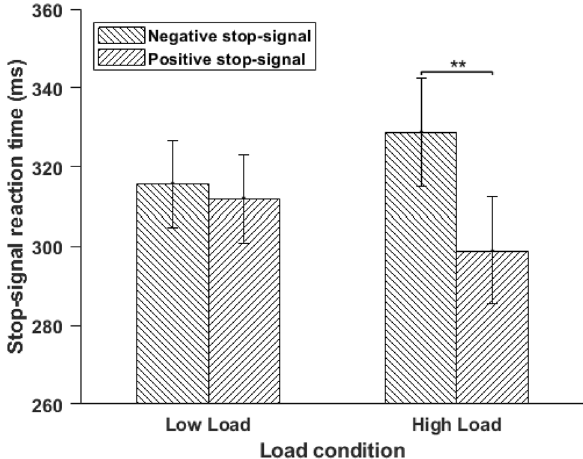
Figure 2. Mean SSRT was plotted as a function of load and emotion for Experiment 1. Vertical lines represent ± 1 within-subject standard error. SSRT: Stop-Signal Reaction Time; ** p <